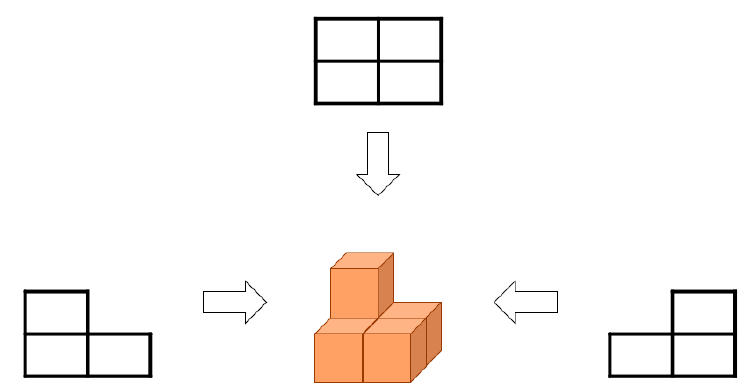
Figure 2. EFA algorithm procedure related to BCICW.